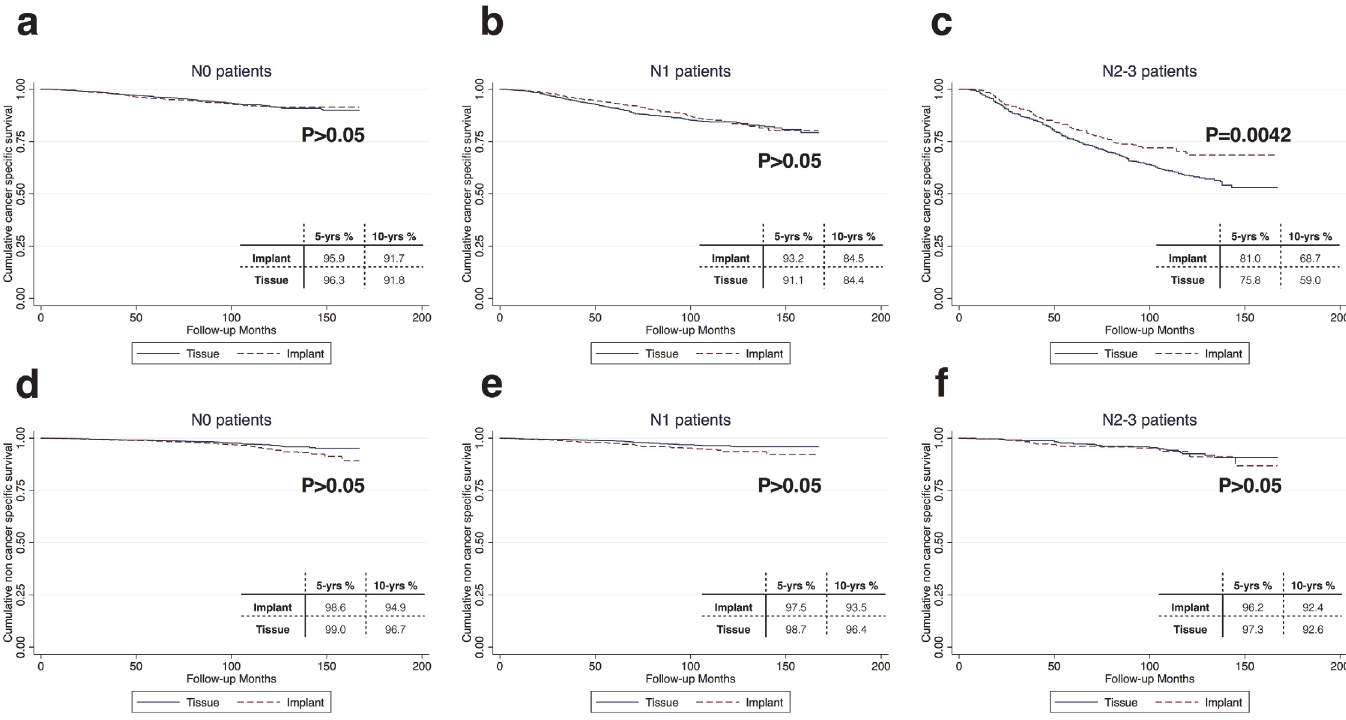
Fig 1. a-c, Cumulative BCSS in patients who underwent tissue and implant reconstruction; d-f, Cumulative non-BCSS in patients who underwent tissue and implant